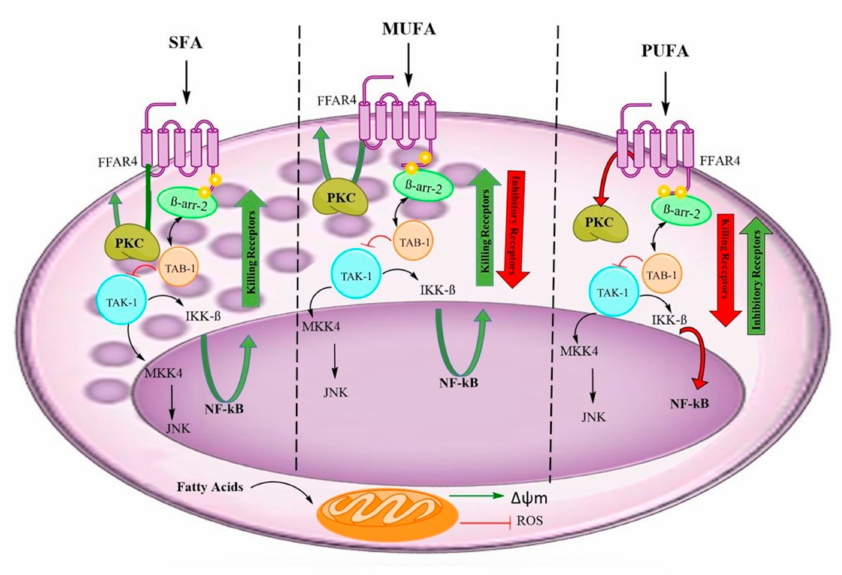
Figure 8. Graphical summary of the e ff ects of fatty acids on NK cells. The postulated e ff ects of saturated (SFA), monounsaturated fatty acids, w9 (MUFA) and polyunsaturated w3, fatty acids (PUFA). The e ff ect of AA, not represented in the picture. FFAR4 corresponds to Free Fatty Acid Receptor 4, β arr-2 corresponds to β arrestin 2, PKC corresponds to Ptotein Kinase C, TAB-1 corresponds to Transforming growth factor beta-activated kinase 1(TAK)-binding protein 1, IIKB corresponds to Inhibitor Of Nuclear Factor Kappa B Kinase Subunit Beta, NF κ B corresponds to Nuclear Factor Kappa B transcription factor, MKK4 corresponds to Mitogen-activated protein kinase (MAPK) kinase 4, JNK corresponds to c-Jun N-terminal kinase, ∆ ψ m corresponds to The mitochondrial membrane potential and ROS corresponds to Reactive Oxygen